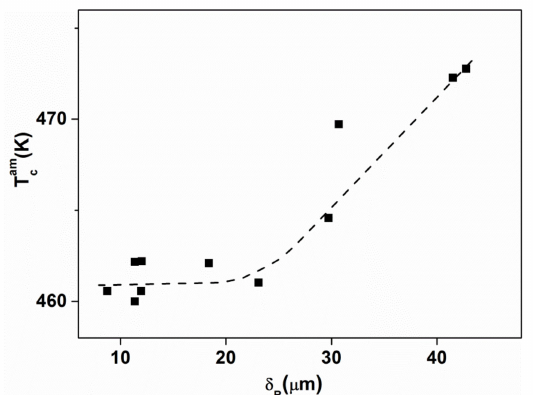
Figure 14. Curie temperature T Cam in the as-quenched state for Fe 25 Ni 55 B 10 Si 10 samples as a function of ribbon thickness. Adopted from [81], with permission from Elsevier, 1984.